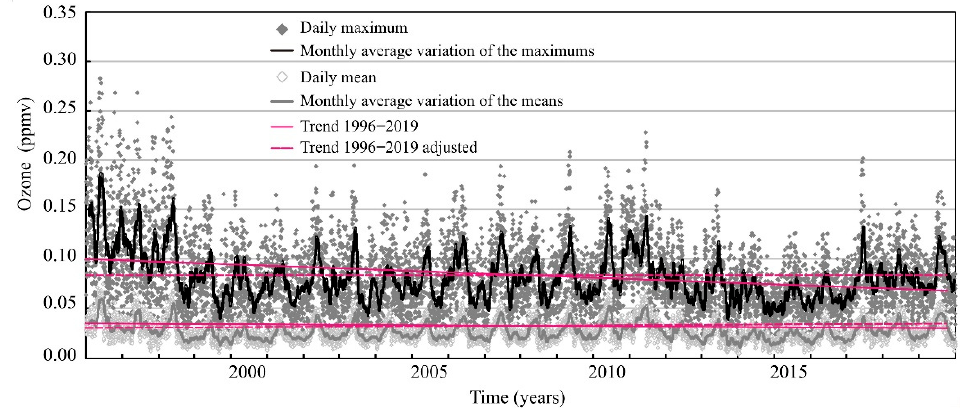
Figure 4. Time series sequences of the ozone in the Guadalajara Metropolitan Area. Table 1. Statistical comparison between typical and atypical periods of ozone concentrations.